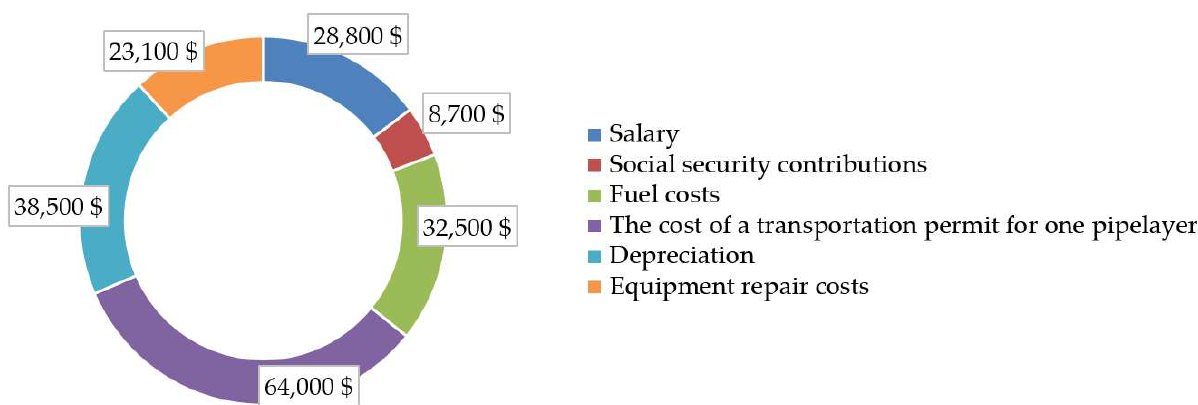
Equipment repair costs (% of equipment cost) 3% The results of the calculation of financial costs are shown in Figure 22.